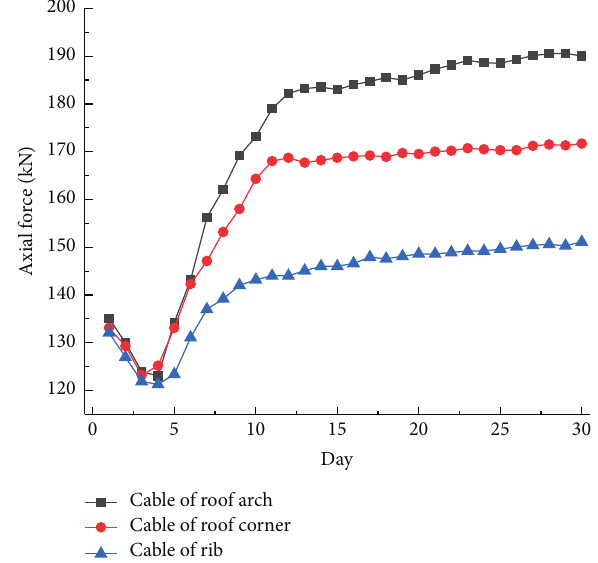
Figure 16: Axial force of the cable in the No. 3